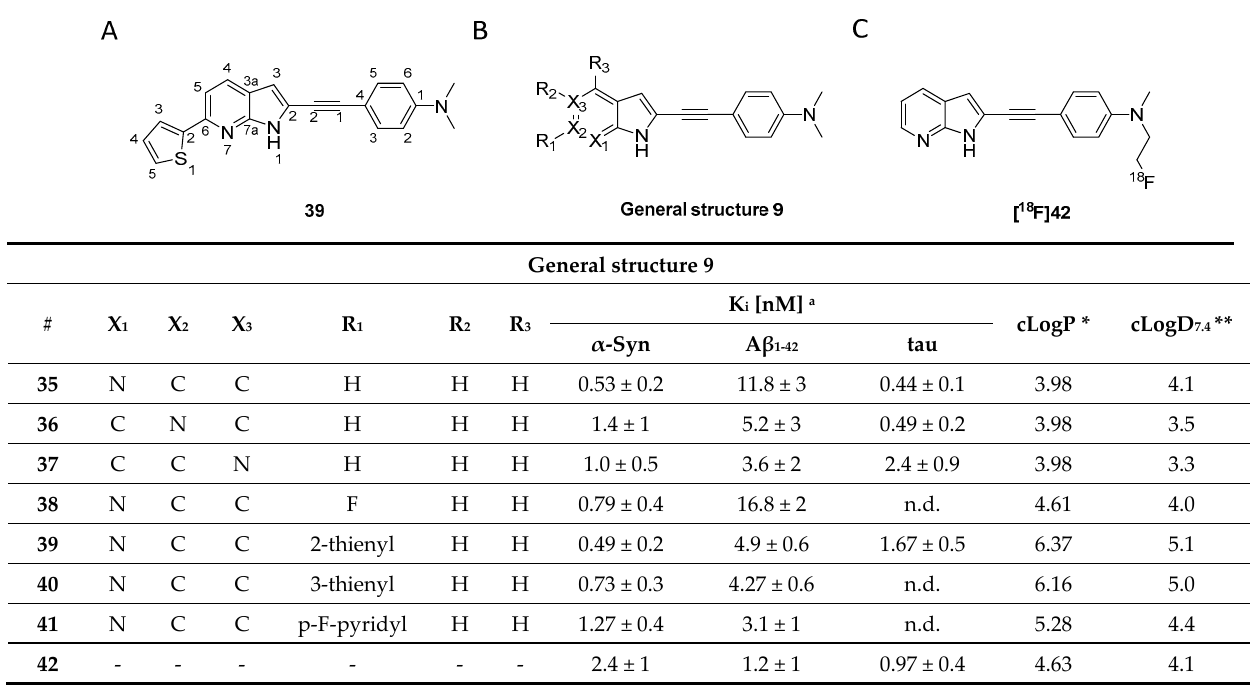
Figure 18. Chemical structures of azaindole derivatives with key properties. ( A ) Chemical structure of compound 39 . ( B ) General structure of azaindole derivatives with identified in vitro K i and K d binding properties [119]. ( C ) Chemical structure of [ 18 F]42 that was used for in vivo study. * clogP values were calculated by BioByte. ** clogD 7.4 values calculated by ACD/Percepta.